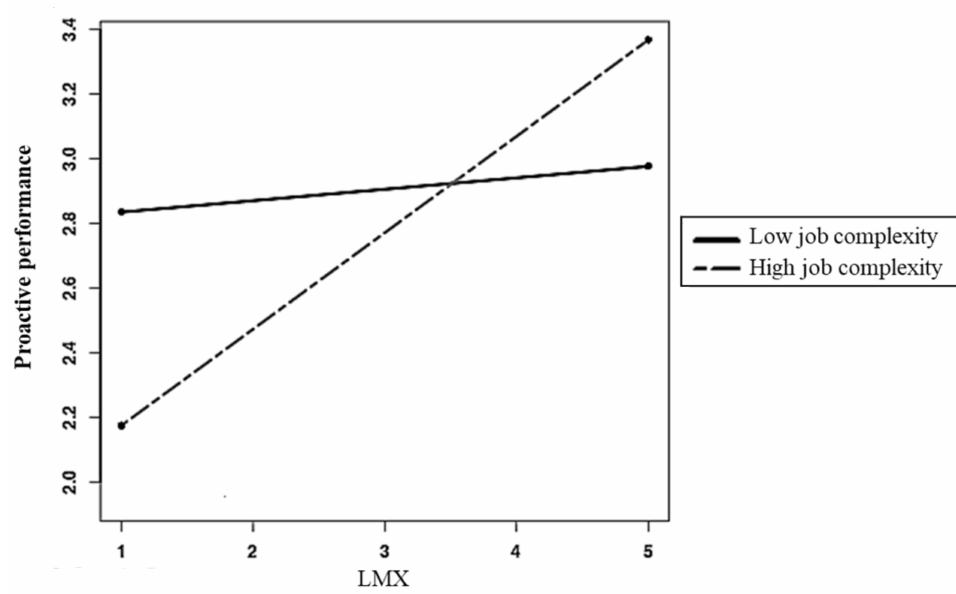
Figure 2. Proactive performance as a function of LMX at ± 1 standard deviation of job complexity.